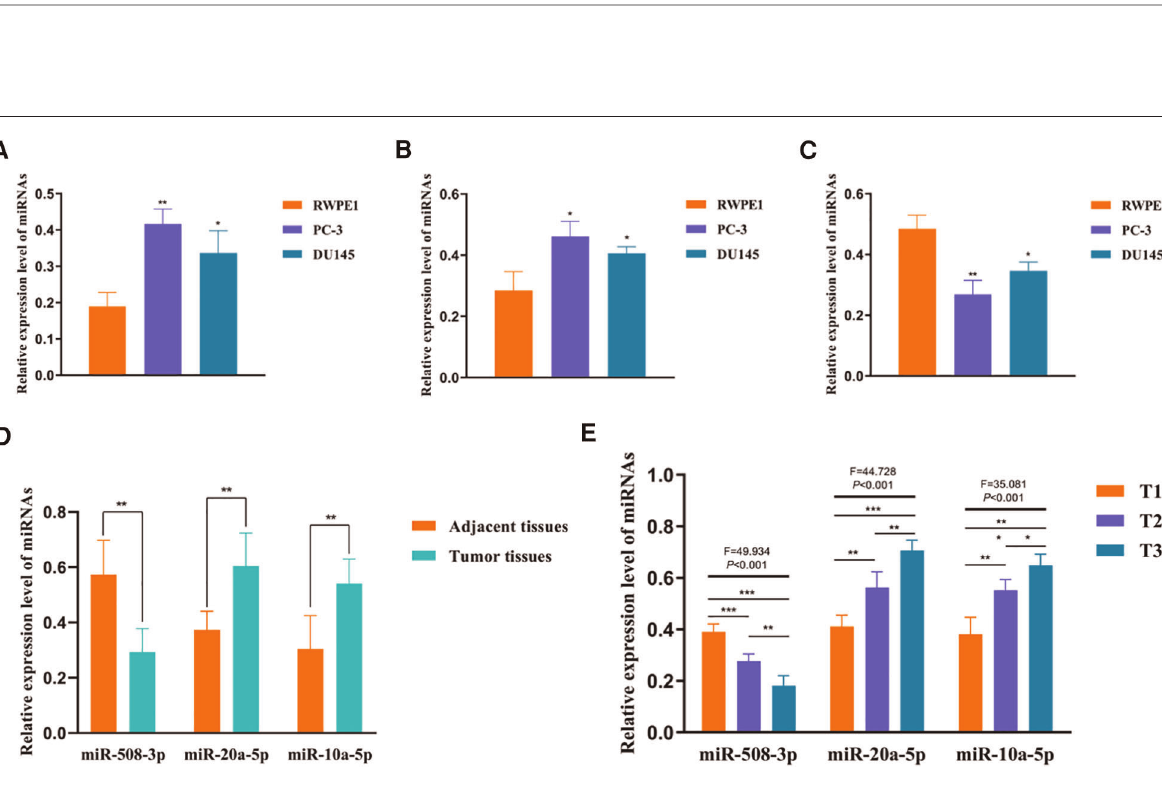
FIGURE 9 Expression levels of sDMIRs and their correlations with T-stage. The expression levels of miR-10a-5p ( A ) and miR-20a-5p ( B ) signi fi cantly decreased in prostate epithelial cell line RWPE1, but miR-508-3p ( C ) exhibited the opposite results. miR-10a-5p and miR-20a-5p were highly expressed in tumor tissues and the expression of miR-508-3p was enhanced in adjacent normal tissues ( D ). Expression level of miR-508-3p rather than miR- 10a-5p decreased in the advanced T-stage ( E